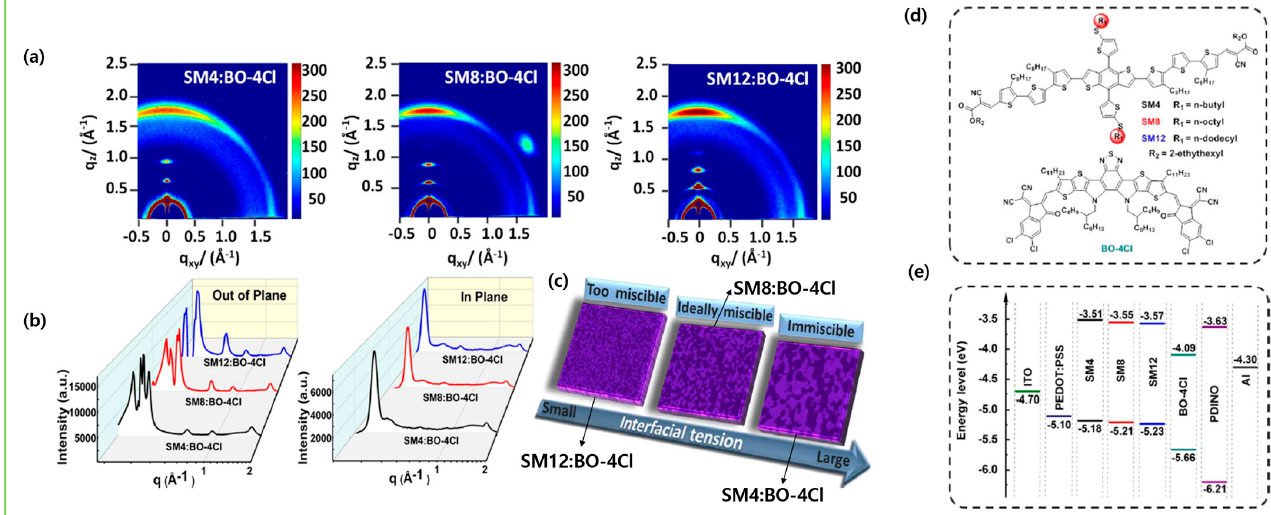
Figure 9. ( a ) Two-dimensional diffraction patterns of the blend films of SM4:BO − 4Cl, SM8:BO − 4Cl, and SM12:BO − 4Cl. ( b ) One-dimensional diffraction profiles in the in-plane and out-of-plane direc- tions for blend films. ( c ) Pictorial illustration of the influence of interfacial tensions on the miscibility. ( d ) Chemical structures of SM4, SM8, SM12, and BO − 4Cl. ( e ) Energy levels of all materials used in [26]. Adapted with permission from [26]. Copyright 2021, American Chemical Society.